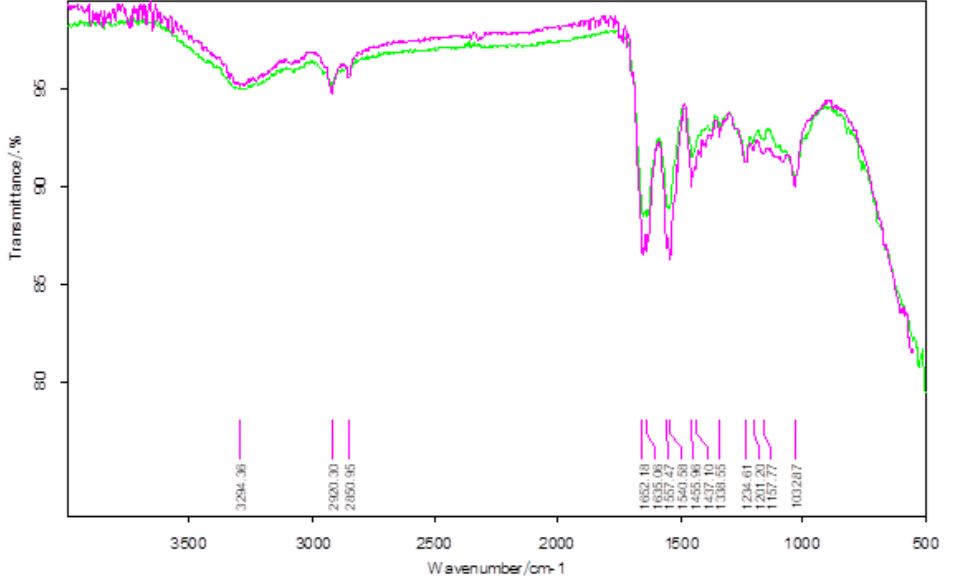
Figure 19. FTIR analysis: BTA untreated skin (purple) and BTA treated skin (green). Tables 15 and 16 retain the wavenumbers of radiation absorbed by the untreated suede skin and coated with a 2 % concentration solution of BPA (Table 15) and BTA (Table